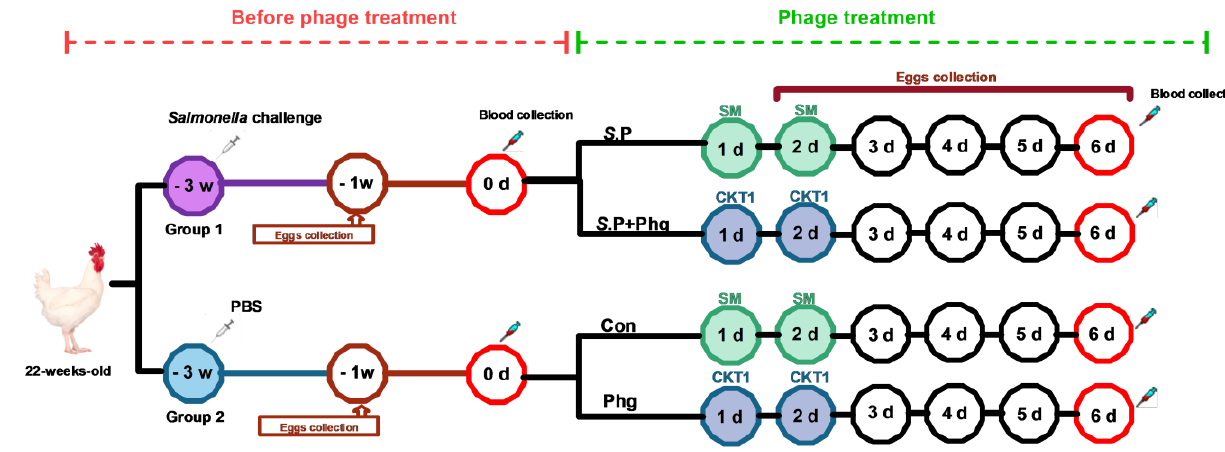
Figure 1. Schematic depicting the experimental design and timeline . For the groups at − 3 week, 10 chickens were used in each group; For the groups at 1 d, 5 chickens were used in each group. The eggs were collected at − 1 week and 2–6 d; serums were collected at 0 d and 6 d; the tissues were collected at 6 d; the total bacterial load in the air was collected at 3 d and 6 d. Group 1 or S. P, only Salmonella challenged; Group 2 or Con, control group; Phg, only phage treated; S. P + Phg, Salmonella challenged and phage treated.